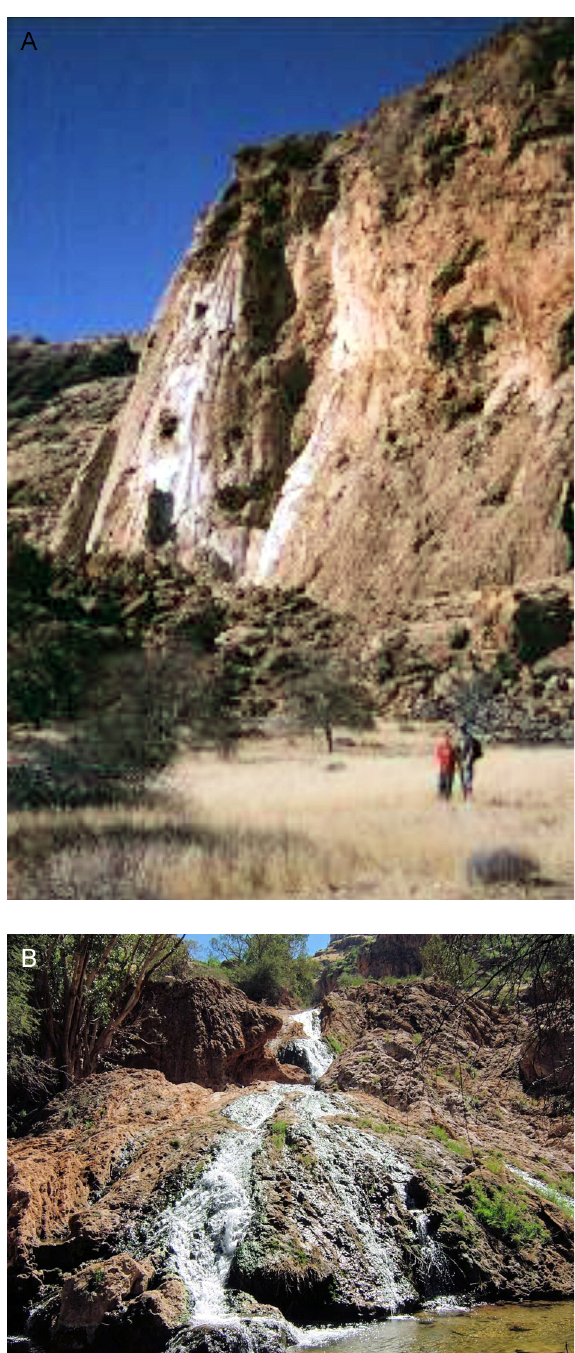
Fig. 8. Constructive waterfalls in Namibia: (A) in Quiver Tree Gorge in the Namib Naukluft Park and (B) at Blasskrantz. Photos: August